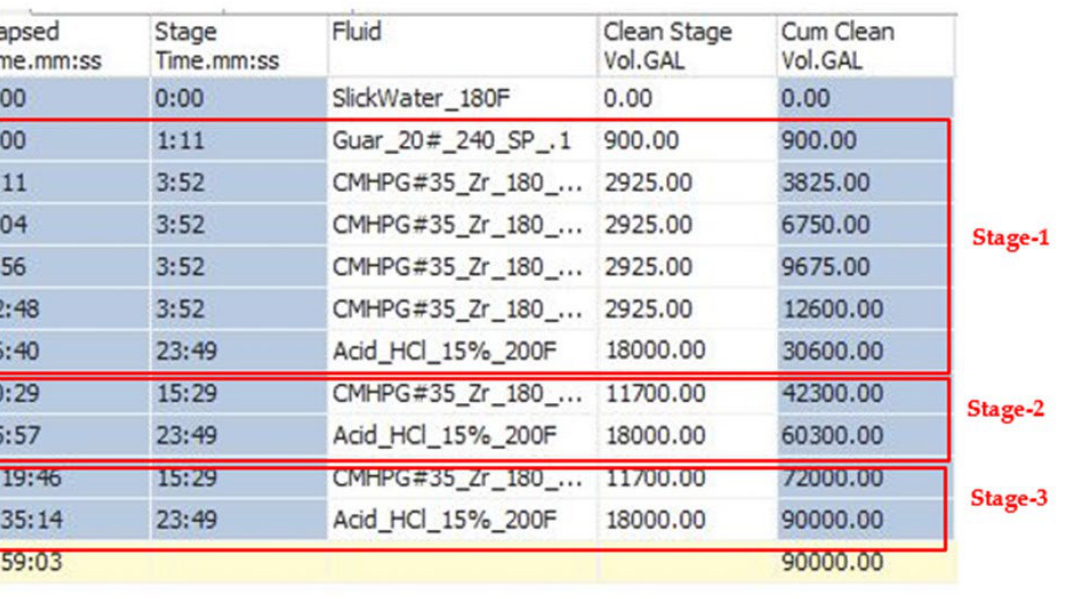
Figure 11. Pumping schedule for optimized condition with 90 K-gal fluid volume, 18 BPM injection rate and three (3) stages.